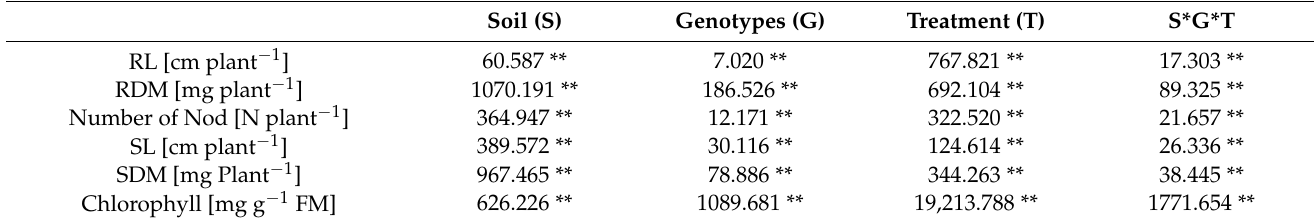
Table 4. Results of three-way analysis of the effect of soil (S), genotypes (G), and treatment (T) and their interaction (S*G*T) on roots length RL [cm plant − 1 ], root dry mass RDM [mg plant − 1 ], number of nodules NN [N plant − 1 ], shoot dry mass SDM [mg plant − 1 ] and chlorophyll content [mg g − 1 FM] in Vicia faba